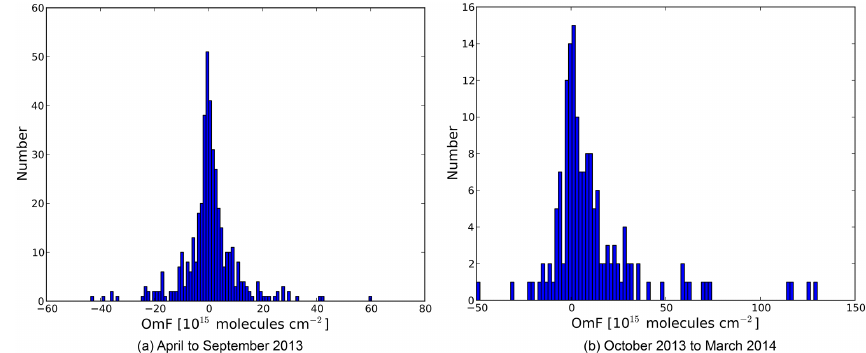
Figure 7. The distribution of the OmF values over 15 polluted cities in summer (a) and in winter (b) . The 15 polluted cities are Baoding, Beijing, Chengdu, Harbin, Hohhot, Guangzhou, Jinan, Shanghai, Shenyang, Shijiazhuang, Tianjin, Wuhan, Xi’an, Xingtai and Zhengzhou.